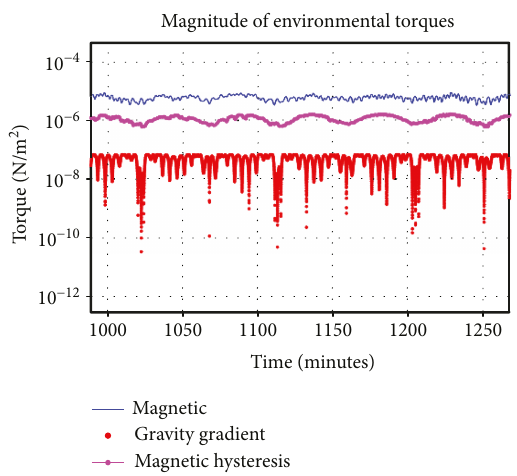
Figure 4: Trace of the hysteresis loop model of HyMu80 created by the Simulink model while a satellite tumbled randomly. Table 2: Satellite description and simulation parameters.